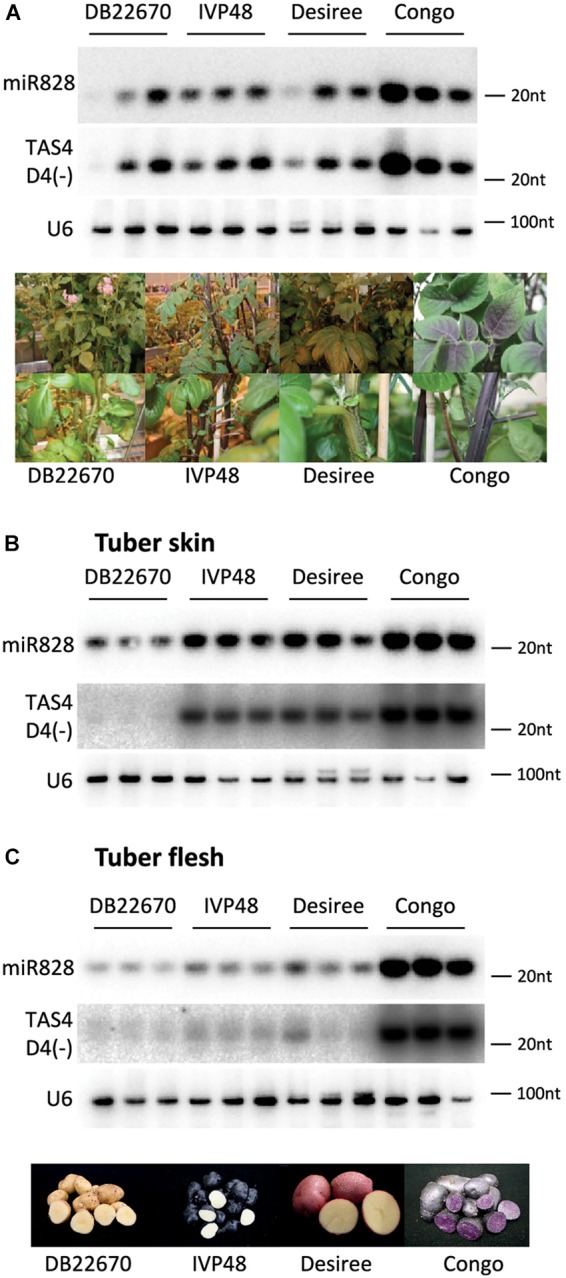
RNA gel blot analysis of small RNAs. Potato leaf (A), tuber skin (B), and flesh (C) tissues were used to detect small RNAs with radioactively labeled probes specific to miR828 and TAS4 D4(-). U6 was used as a loading control. Three biological replicates of plant tissues were used for small RNA detection indicated by solid line and the name of cultivars. Photos on (A,C) show leaves, stems, and tubers of cultivars.